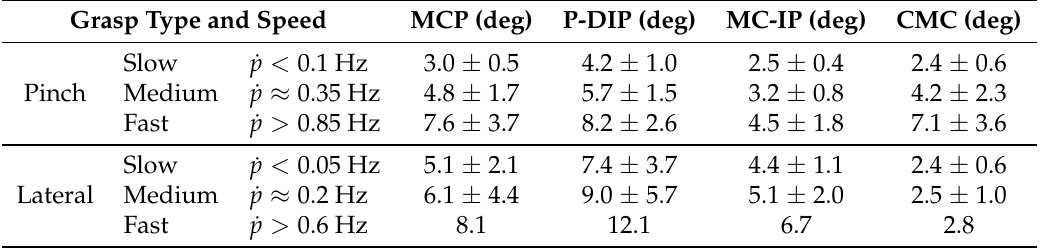
Figure 8. Aggregated cross-results of operator’s task execution speed and RMSE of HX motion from the desired, respectively for ( a ) pinch and ( b ) lateral grasps. The histogram bars represent the RMSE in degrees, while each task repetition is reported as a circle dot. The black small line in top of each histogram represents the mean speed, the black winds around it represent the standard deviation, and the gray wind indicates mean speed plus twice the standard deviation. Results are divided among the four DoM. Table 2. Mean value ± standard deviation of ε , classified according to the operator self-chosen velocity ˙ p